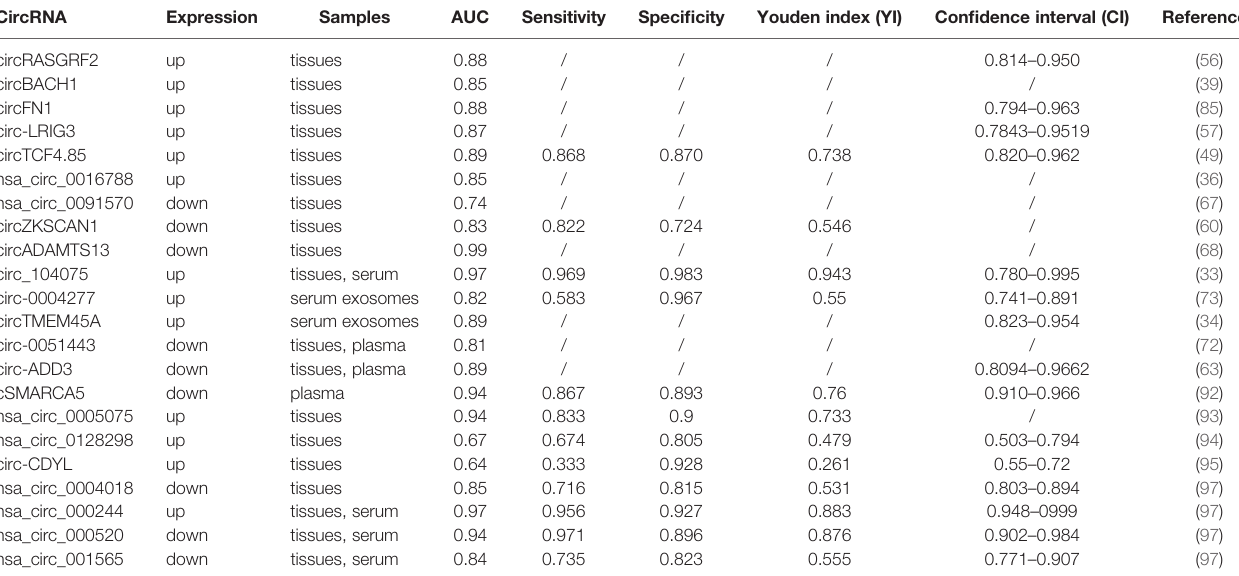
TABLE 2 | CircRNAs as diagnostic biomarkers for HCC.